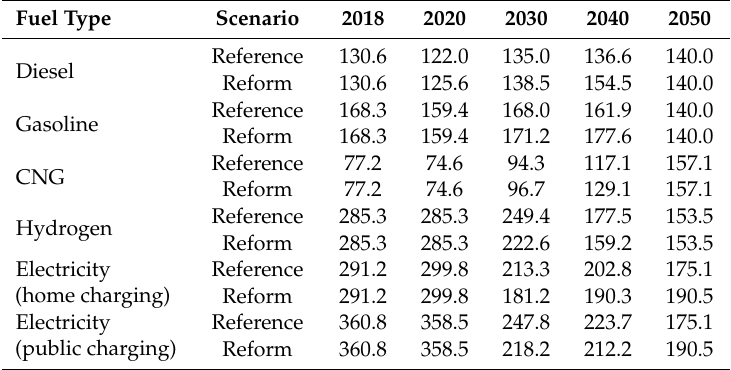
Table A1. Fuel retail price estimations until 2050 in EUR / MWh.